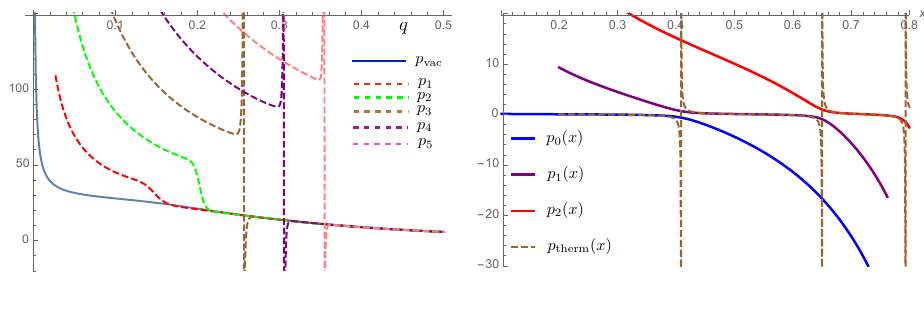
Figure 20 . Left: plots of p vac ( q ) and p n ( q ) for n = 1 ; : : : ; 5 on the real q -axis. Right: semi-classical results in section 3.3 (di(cid:11)erent parameters picked) for qualitative